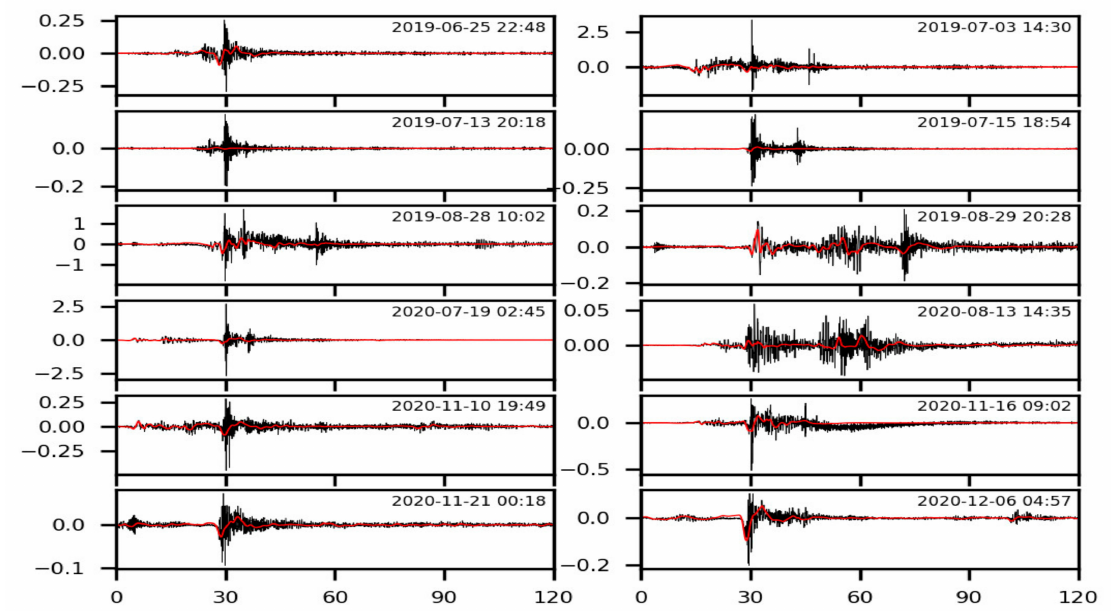
Figure 17. Seismograms of the 12 explosions, here considered as case studies, as recorded from station STRA, East component (see Figure 1 for station location). The red lines represent the filtered signal in the VLP frequency band (0.05–0.5 Hz). The vertical scale is expressed in 10 6 counts. The filtered signal is scaled by a factor of 2. The time on the horizontal axis is in